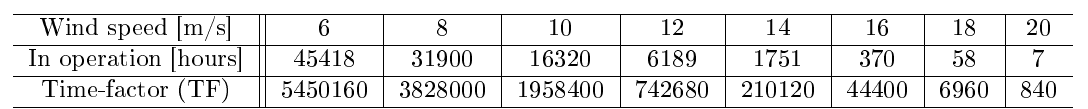
Table 2: Time scaling for 30 seconds simulation time (no adjustment).